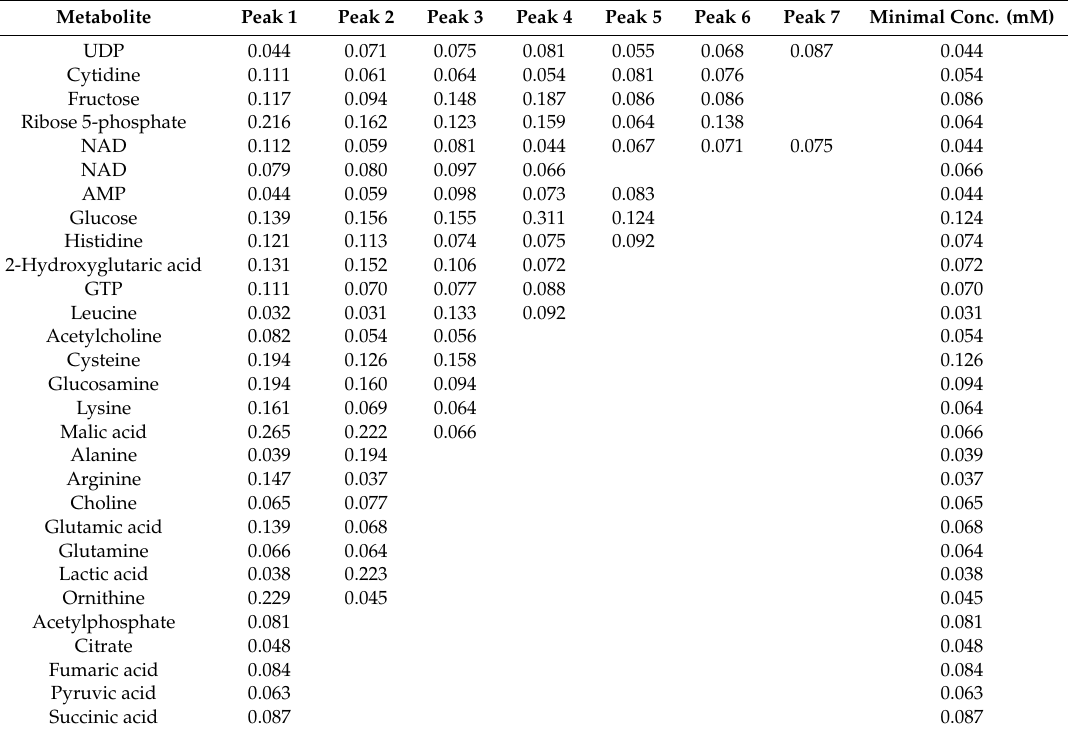
Table 3. Limit of quantification (LOQ) for measured metabolite resonances.